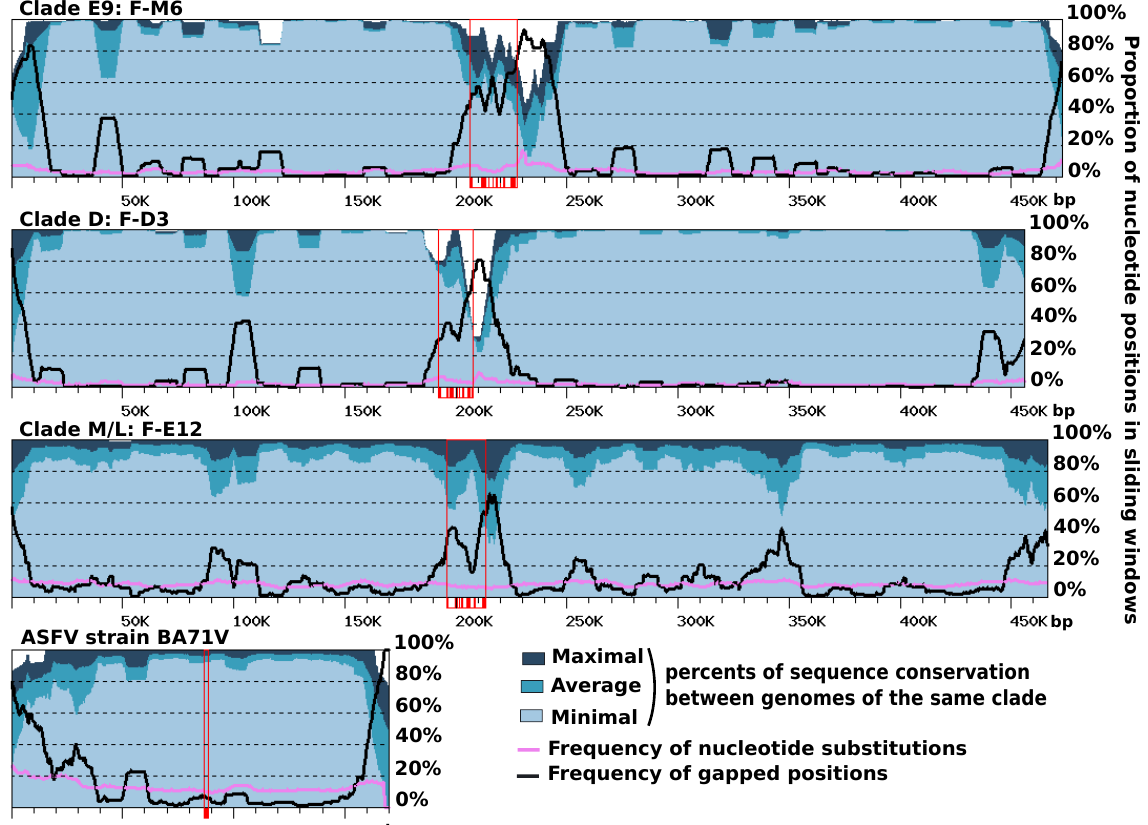
Figure 4. Sequence conservation along viral chromosomes. The graphs represent sequence conservation along reference genomes of FVs (i.e., F-M6 for clade E9, F-D3 for clade D, and F-E12 for clade M / L) and African swine fever viruses (ASFVs) (strain BA71G). Each reference FV genome was aligned against the other FV genomes of the same clade using BLASTN (evalue < 1E-15). The reference ASFV genome was aligned against 12 other sequenced ASFV genomes available in Genbank. The resulting alignments were parsed to compute various statistics within 10 Kb windows slid along the genomes with a 1 Kb step. The dark, medium and light blue areas represent maximal, average and minimal levels of within-clade sequence conservation (global identity) within windows. The mauve and black curves represent the frequencies of positions containing a nucleotide substitution or a gap, respectively, in any alignment within windows. Open red rectangles indicate the positions of the MCP genes, with individual exons shown with shaded boxes below the